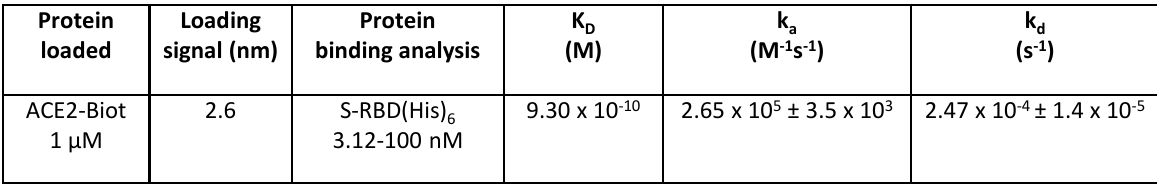
Figure 3. Monitoring of the SARS-CoV-2 S-RBD/ACE2 interaction using Bio-Layer Interferometry. Bio-Layer Interferometry (BLI) experiments were performed using Streptavidin biosensors and 1 µM of ACE2-Biot coated for 500 s in order to reach a binding value of ~2.7 nm. Baseline with the reaction buffer was measured for 60 s. For the association step, each loaded biosensor was dipped into serial dilutions of S-RBD(His) 6 (from 3.12 nM to 100 nM) for 300 s. The dissociation step of the bound S-RBD(His) 6 was monitored by dipping the biosensor back into the reaction buffer for 300 s. Control experiments were performed to measure non-specific binding and included binding of reaction buffer with loaded biosensor (data subtracted) and binding of 100 nM of S-RBD(His) 6 with no ACE2-Biot loaded onto the biosensor. Sensorgrams curves shown in ( A ) were plotted using Prism 5.0 software (Graphpad Software, La Jolla, CA). The association and dissociation experimental curves were global fitted using a 1:1 binding model with the ForteBio Blitz pro 1.1 software. Kinetic binding parameters (k a , k d ) and the equilibrium dissociation constant (K D ) were determined and reported in ( B